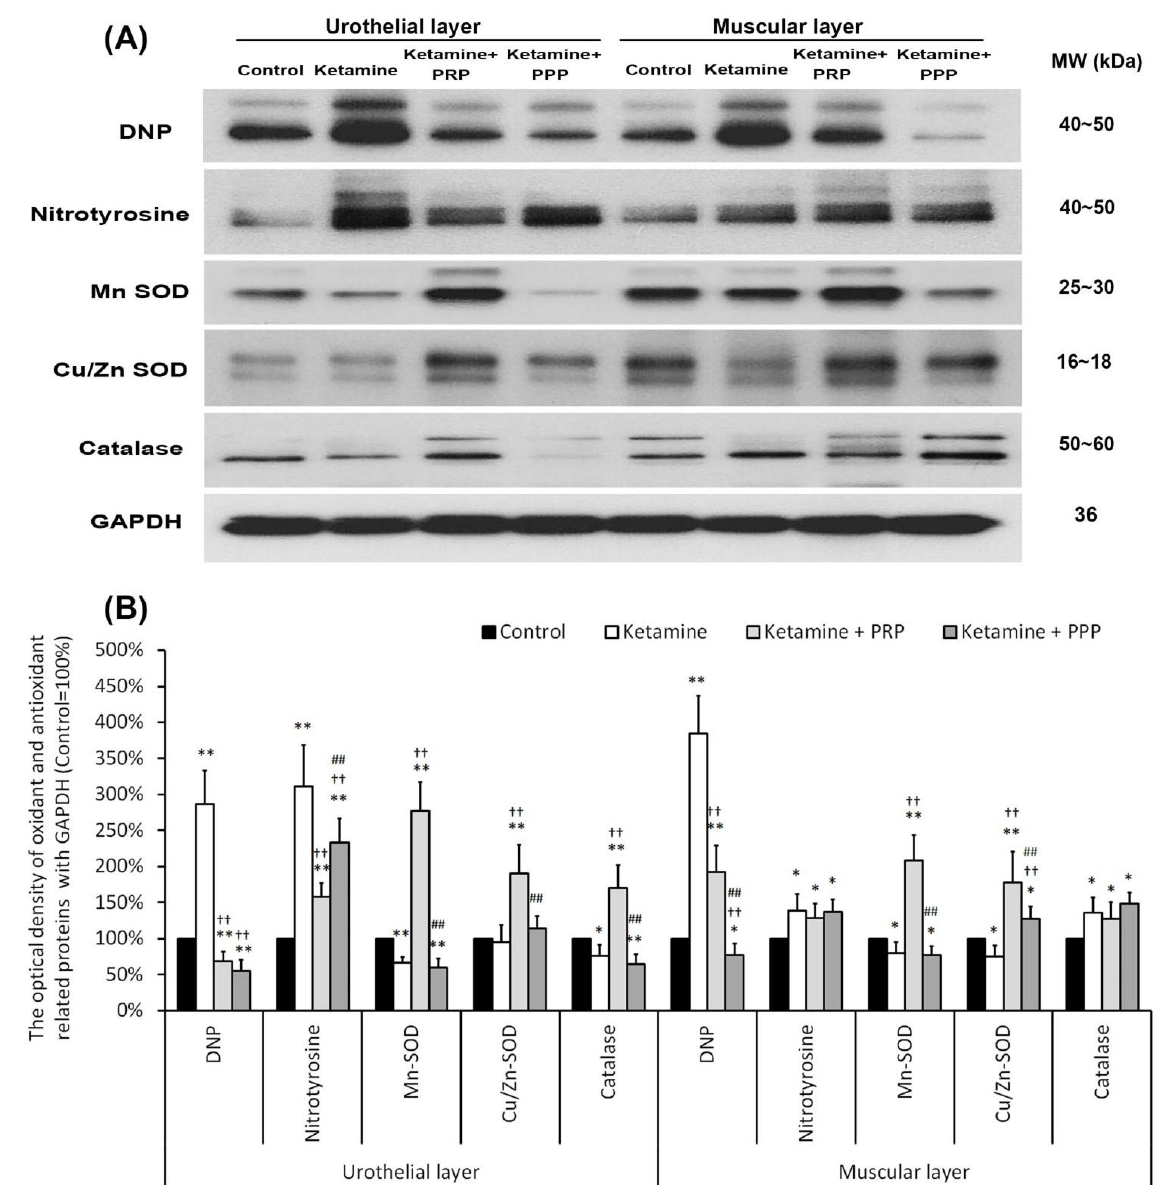
Figure 6. PRP treatment reduced bladder oxidation and enhanced anti-inflammation enzymes ex- pression. Western blotting analysis for oxidative markers (DNP and nitrotyrosine) and antioxidant enzymes (MnSOD, Cu/ZnSOD and catalase) expressions were measured in each group (A). Quan- tifications of the percentage of oxidative markers and antioxidant enzymes expressions to β -actin were shown (B). The expressions of DNP and nitrotyrosine were significantly increased in the ket- amine, but were decreased in the ketamine + PRP group and the ketamine + PPP group. The expres- sions of antioxidant enzymes were meaningfully increased in the ketamine + PRP group. Con- versely, administration with PRP meaningfully decreased the expression levels. Results were nor- malized as the control = 100%. Data were expressed as means ± SD for n = 6, * p < 0.05; ** p < 0.01 versus the control group; †† p < 0.01 versus the ketamine group; ## p < 0.01 versus the ketamine + PRP